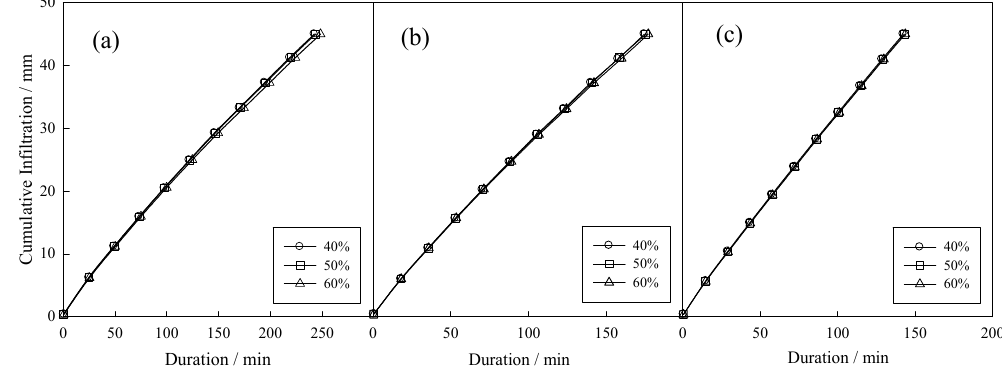
Figure 6. Effect of initial SWC on film hole infiltration: ( a ) silt loam γ d = 1.30 g·cm − 3 ; ( b ) sandy Loam γ d = 1.35 g·cm − 3 ; and ( c ) loamy sand (the percentage is the percentage of field capacity).